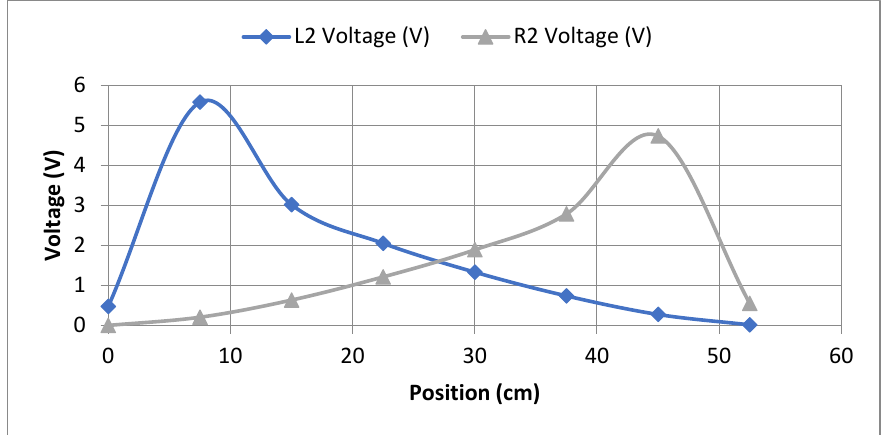
Figure 9. L2 and R2 sensors’ voltage reading for a 0.75 m/s load speed.